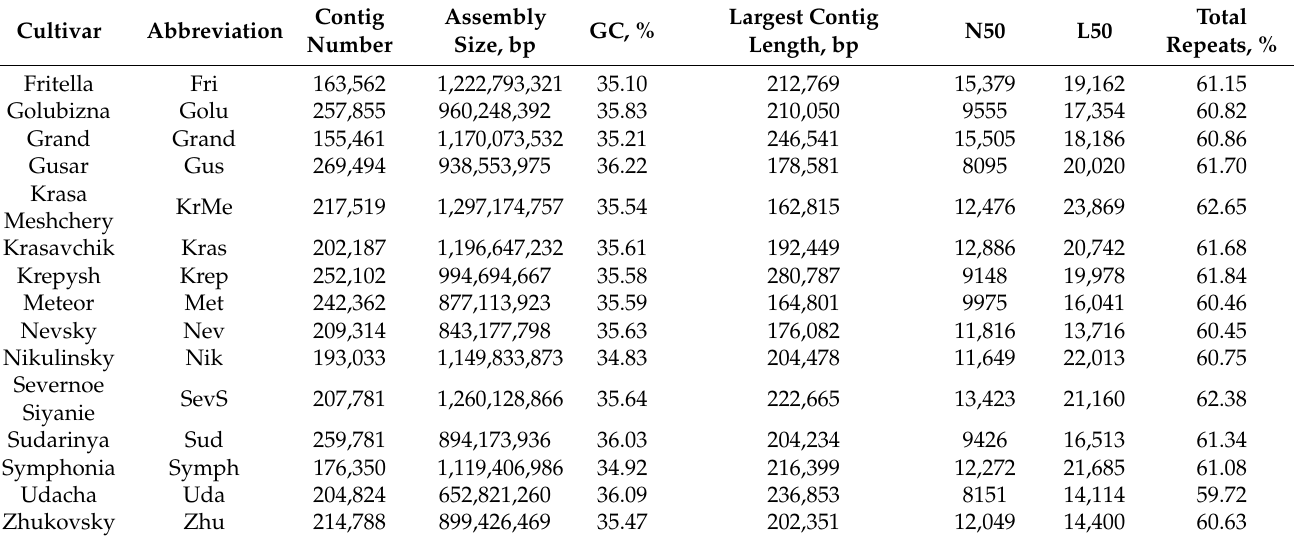
Table 1. Genome assembly statistics of potato varieties cultivars grown in Russia after filtering of short contigs (<1000 bp) without